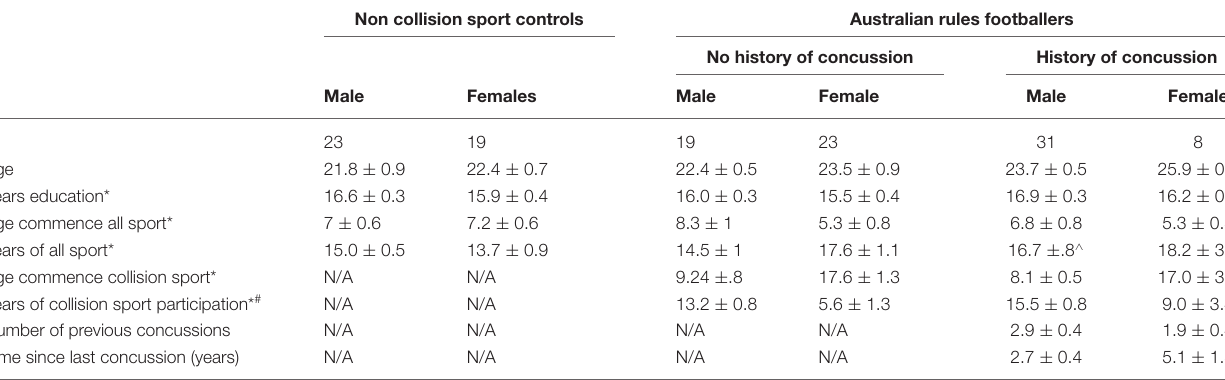
TABLE 2 | Demographic results for non-collision sport controls, and Australian rules footballers with and without a history of